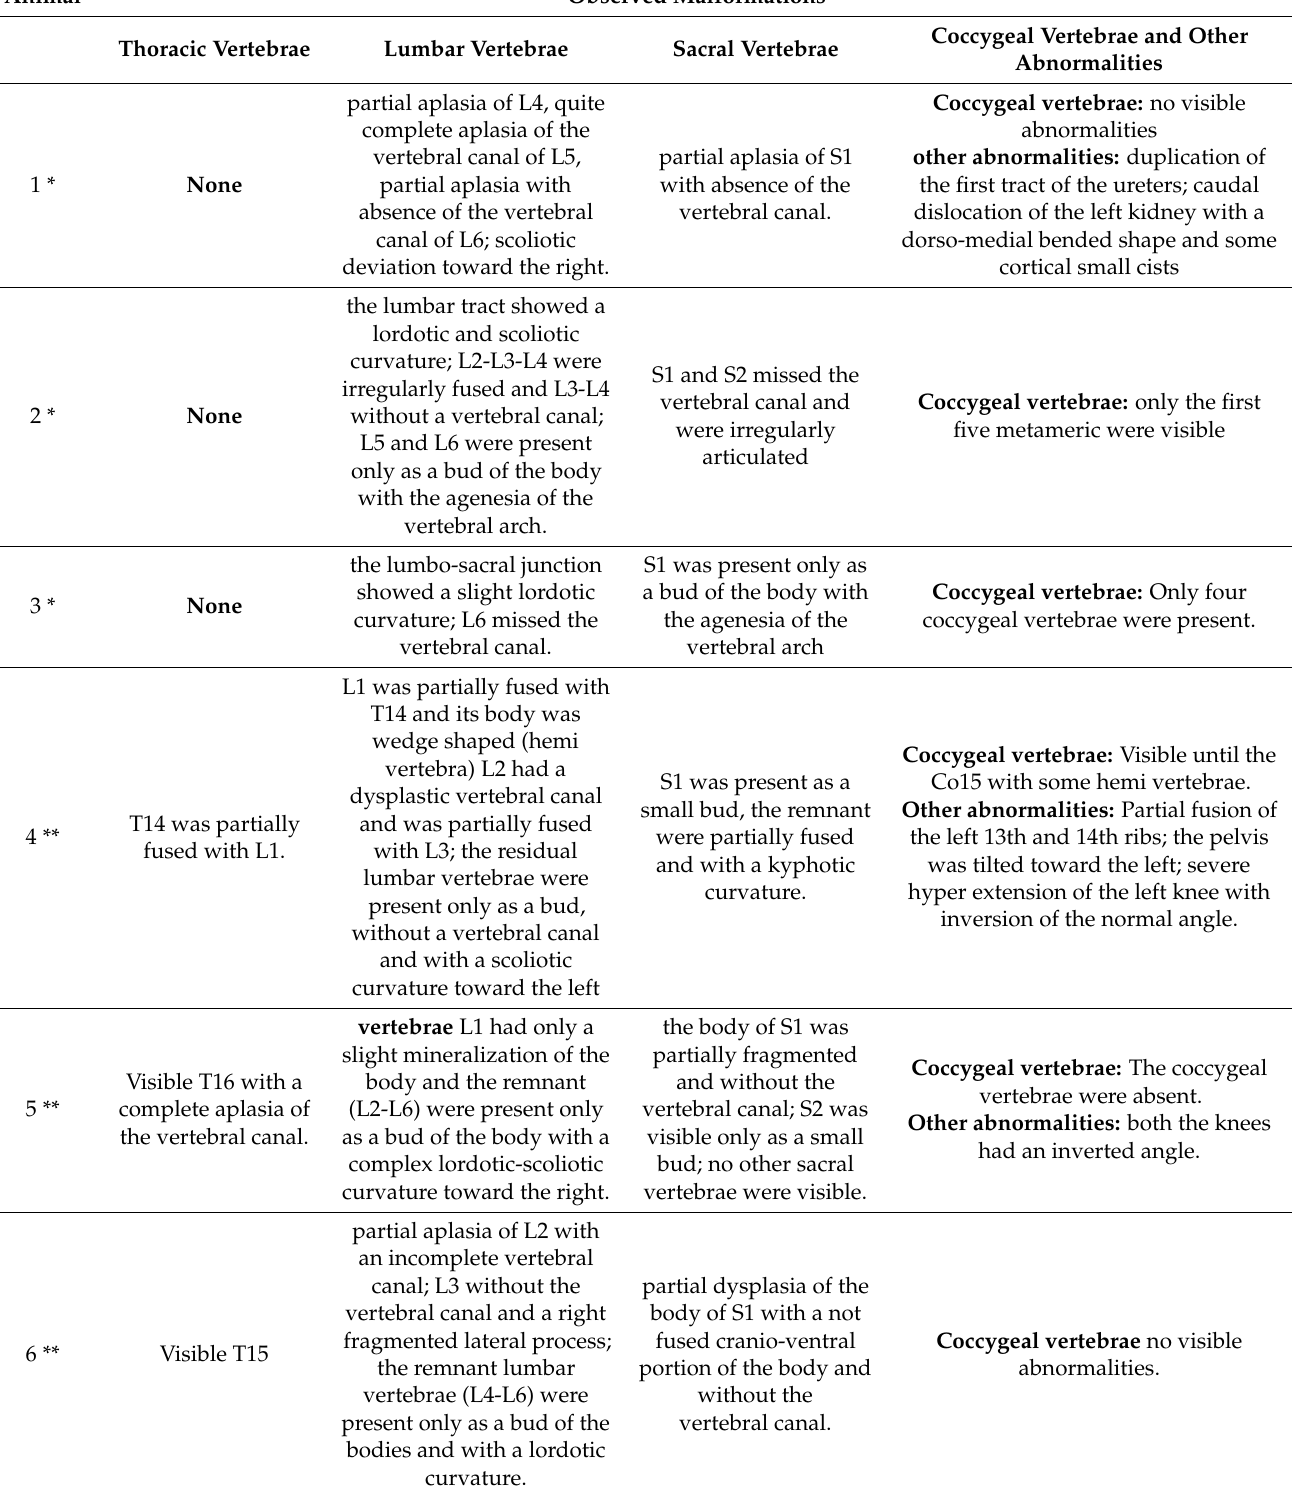
Table 1. Skeletal malformations of the assessed animals. * first-birth animals ** second-birth animals.